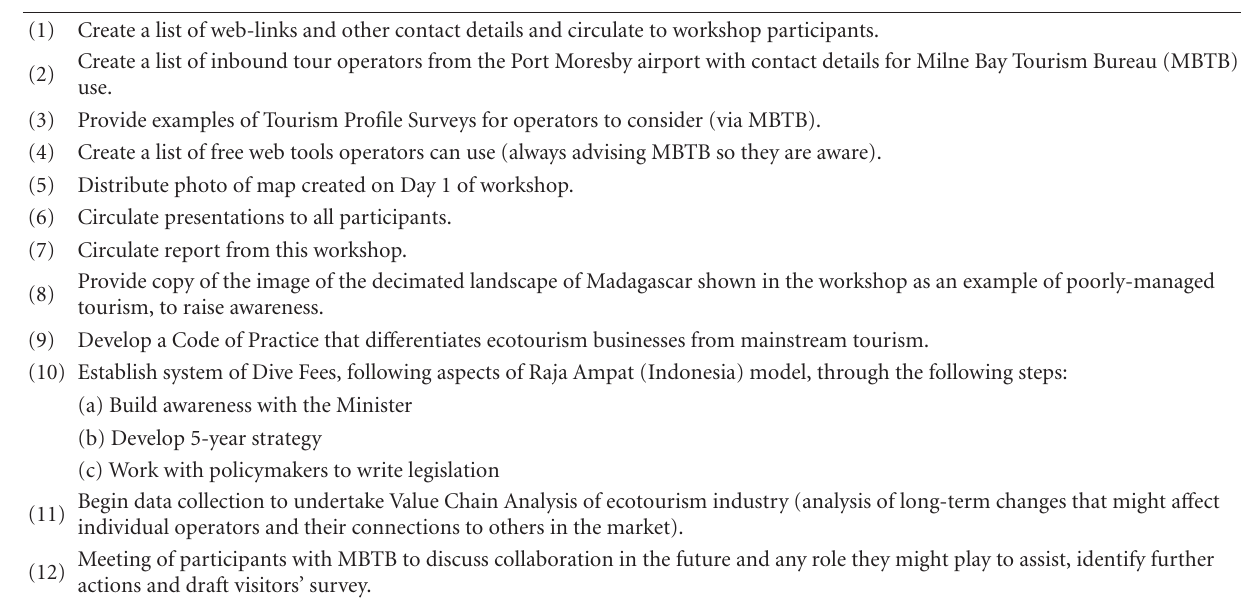
Table 3: Action items identified during the workshop to support goals identified in scenario process. Each item was assigned to an individual or group to